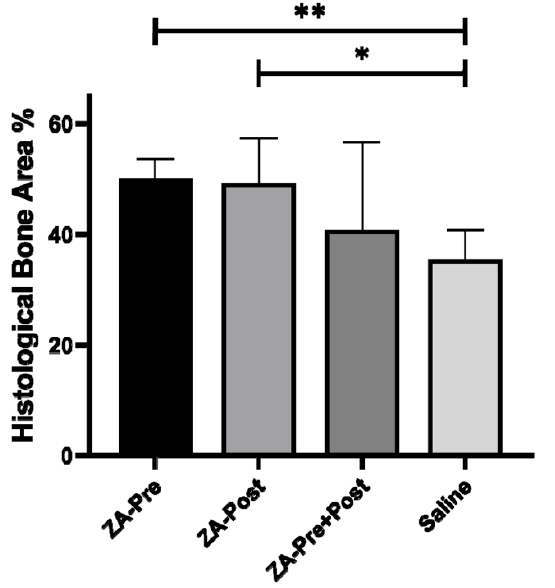
Figure 4. Bar graph with standard deviation indicating the mean quantitative histomorphometric values of bone area percentage (BA%) for the different study groups. Statistically significant difference between the mean values: ** indicates p = 0.031, * indicates p = 0.043.